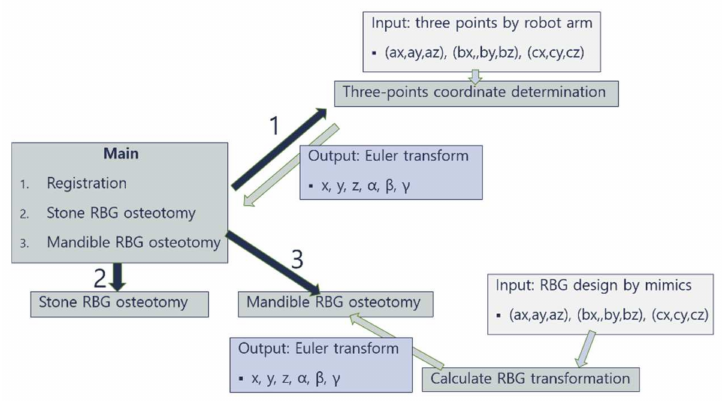
Figure 6. Workflow diagram for the autonomous robot osteotomy